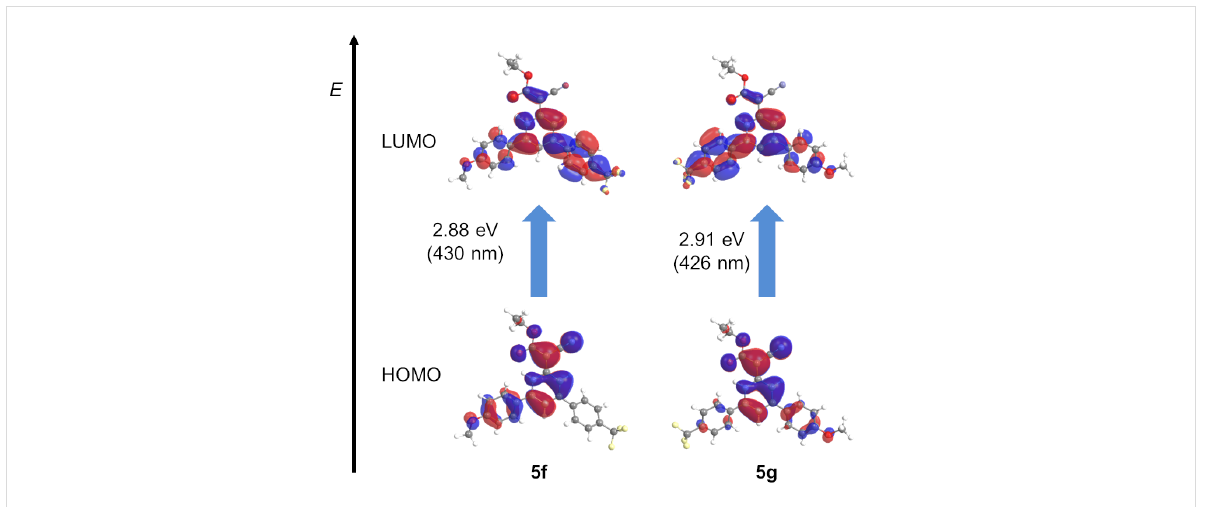
Figure 16: Selected DFT-computed (B3LYP 6-311G**) Kohn–Sham FMOs for 1 H -pyridines 5f and 5g representing contributions of the longest wave- length Franck–Condon absorption bands.